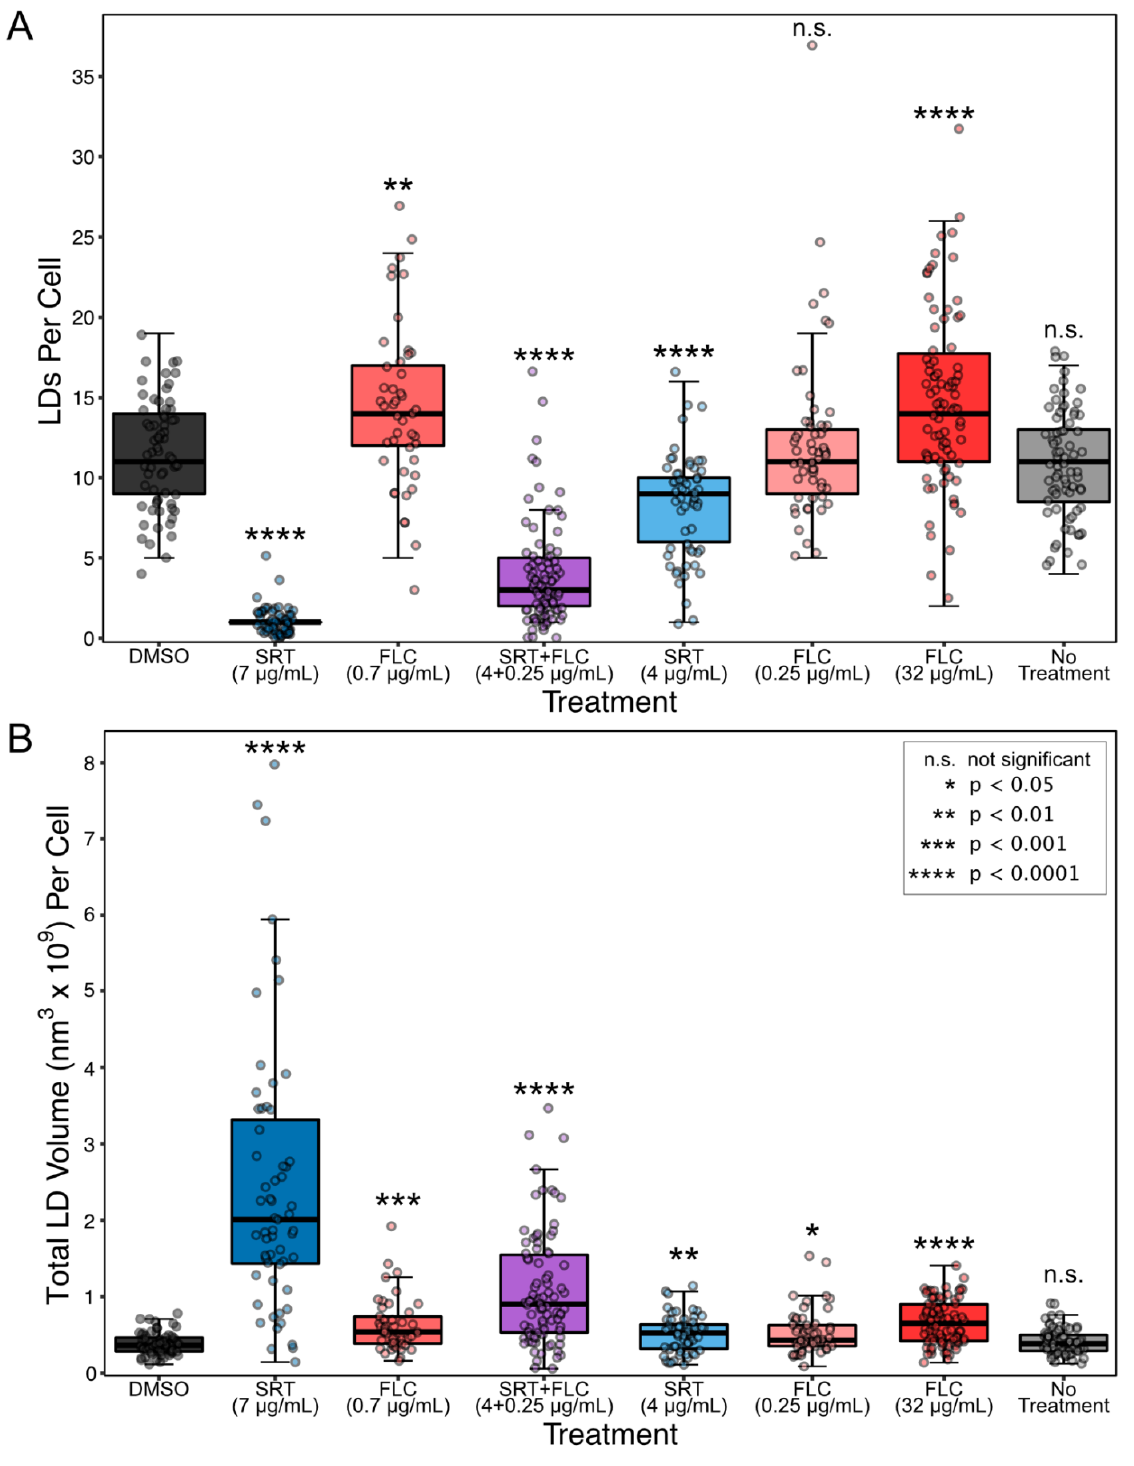
Figure 2. The different drug treatments exert distinct effects on C. neoformans LDs after 12 h. ( A ) Effect of SRT on the number of LDs per cell. Significant differences in the number of LDs per cell between DMSO and the other treatments were evaluated using pairwise Welch’s t -tests. Reported p-values were adjusted using Holms’ correction to account for multiple comparisons. ( B ) Effect of SRT on the total volume of cellular LDs in C. neoformans . Significant differences in the LD volume per cell between DMSO and the other treatments were evaluated using pairwise Welch’s t -tests as in ( A ).